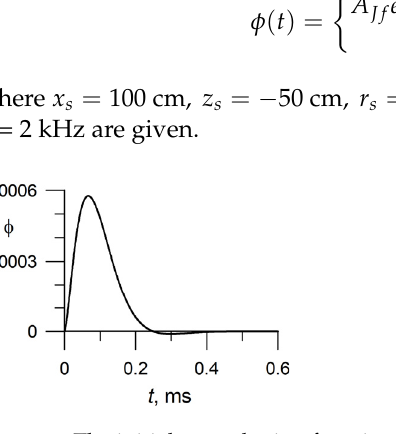
Figure 3. The initial perturbation function 𝜙(𝑡) .